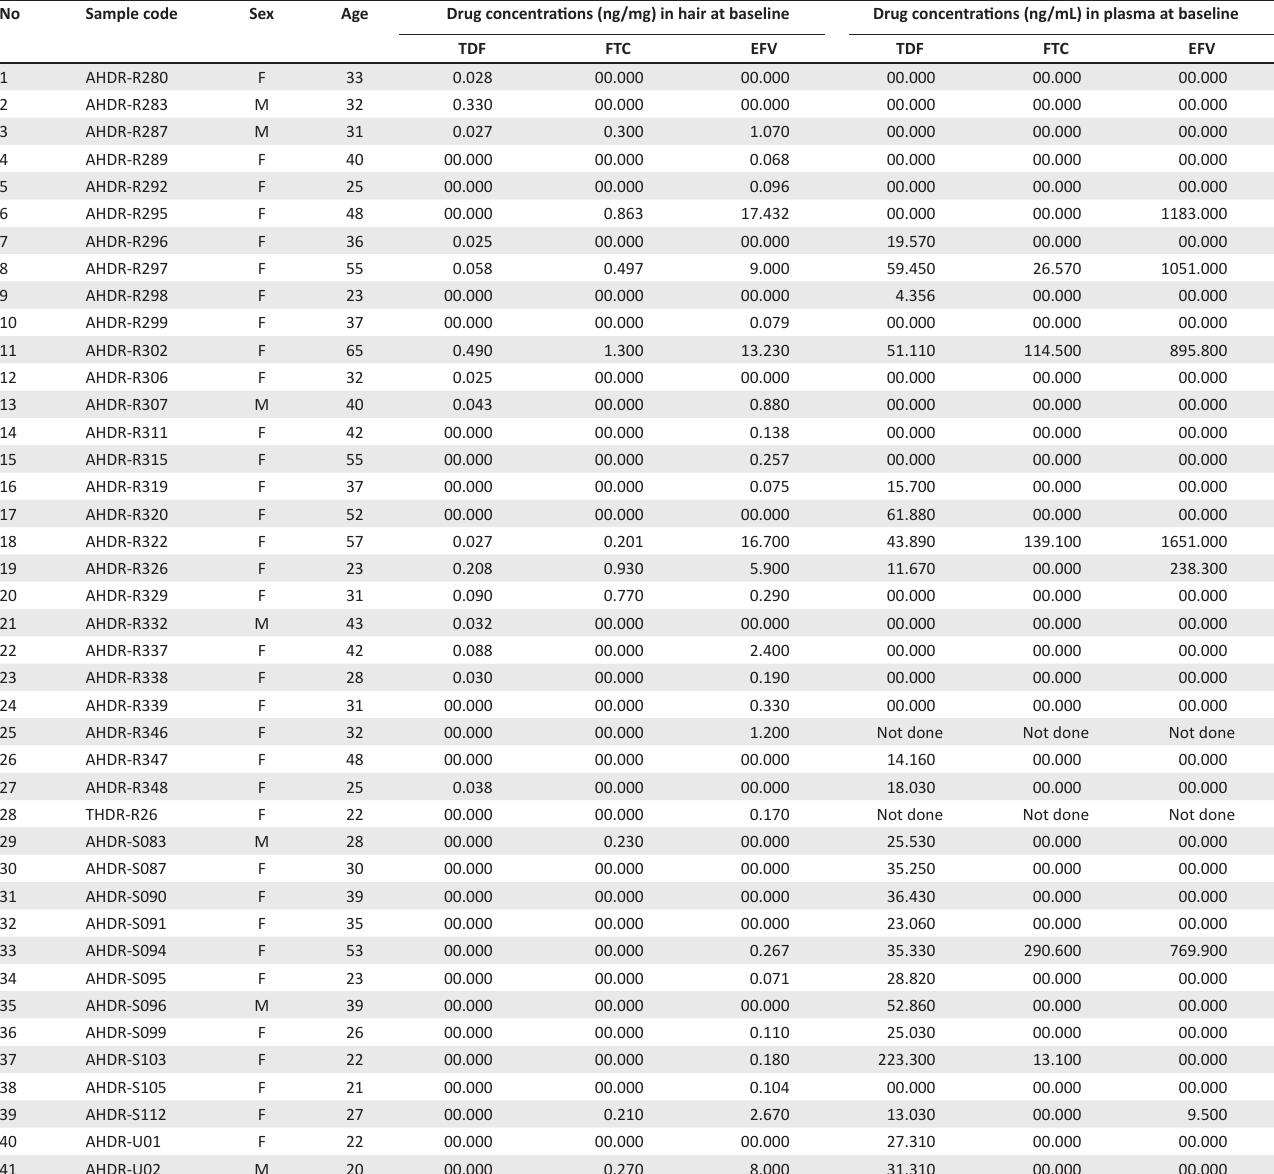
TABLE 2: Characteristics of participants with at least one antiretroviral drug detected in hair or plasma prior to treatment initiation. No Sample